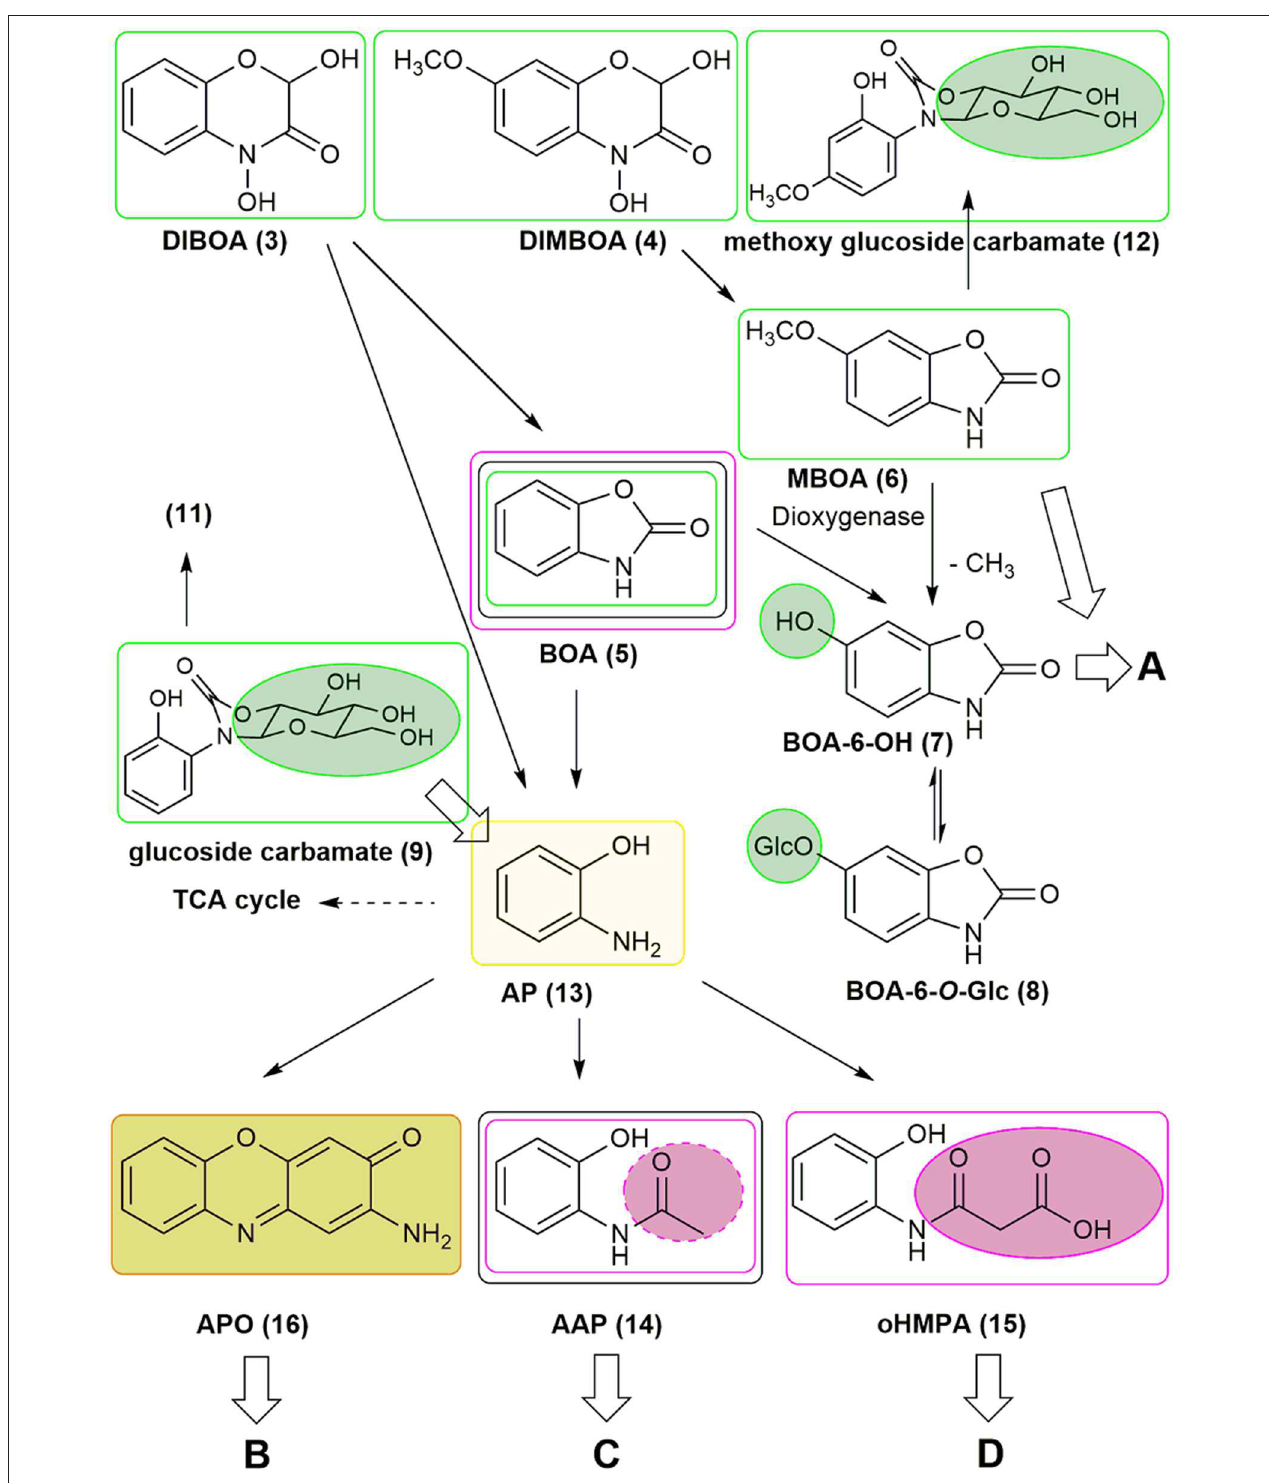
FIGURE 1 | Metabolism of benzoxazinoids by plants and microorganisms. The pathways A, C, and D are further explored in Figures 7 , 11 . Green circles and lines: plant compounds and derivatives produced by plants. Purple circles and lines: fungal compound conversions. Gray lines: bacterial compound conversions. The light green line marks AP as a pivotal molecule in degradation processes and as a precursor for subsequent conversions. The olive green background depictures APO as a precursor for subsequent conversions (pathway B, not considered in this study).